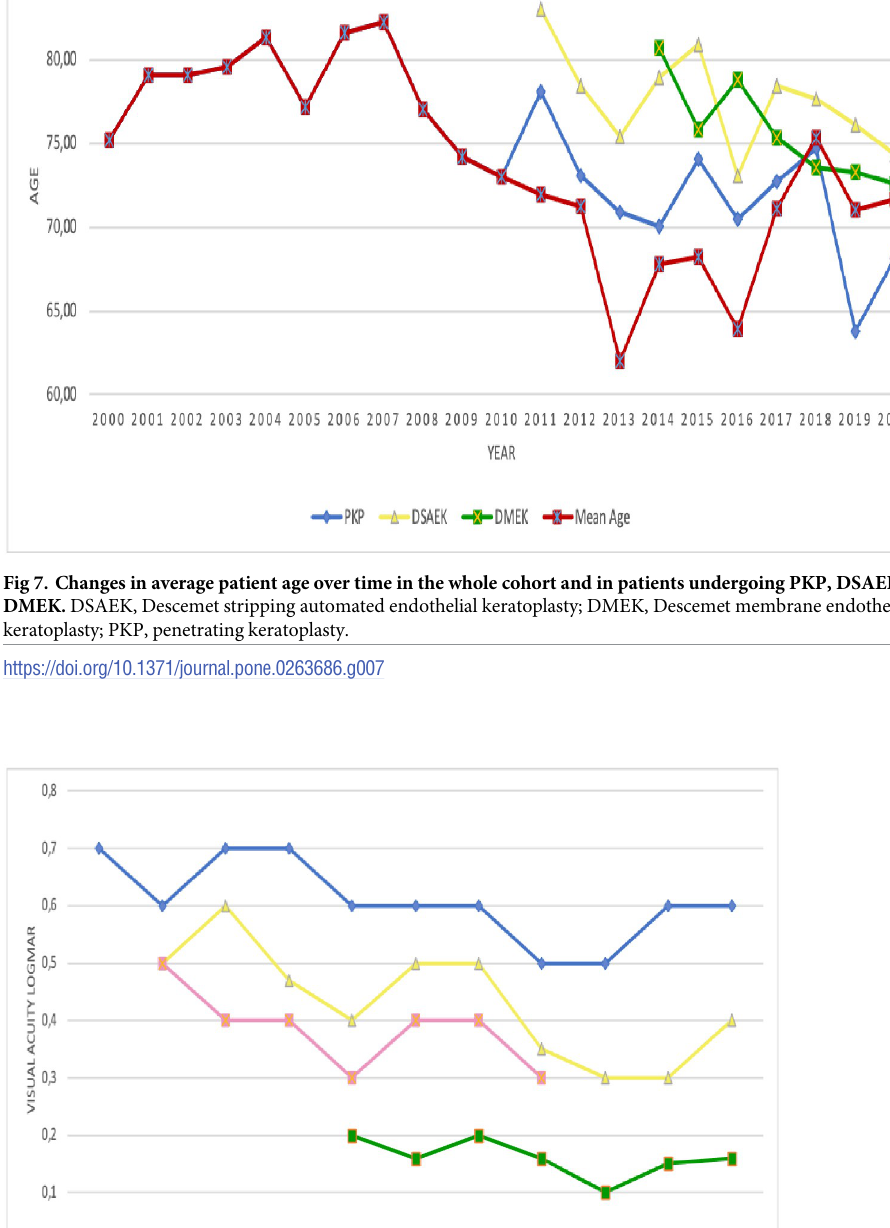
PLOS ONE | https://doi.org/10.1371/journal.pone.0263686 April 29,